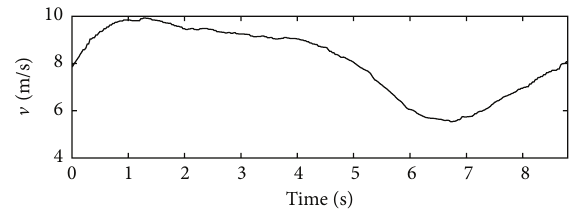
Figure 22: Velocity of obstacle avoidance at high